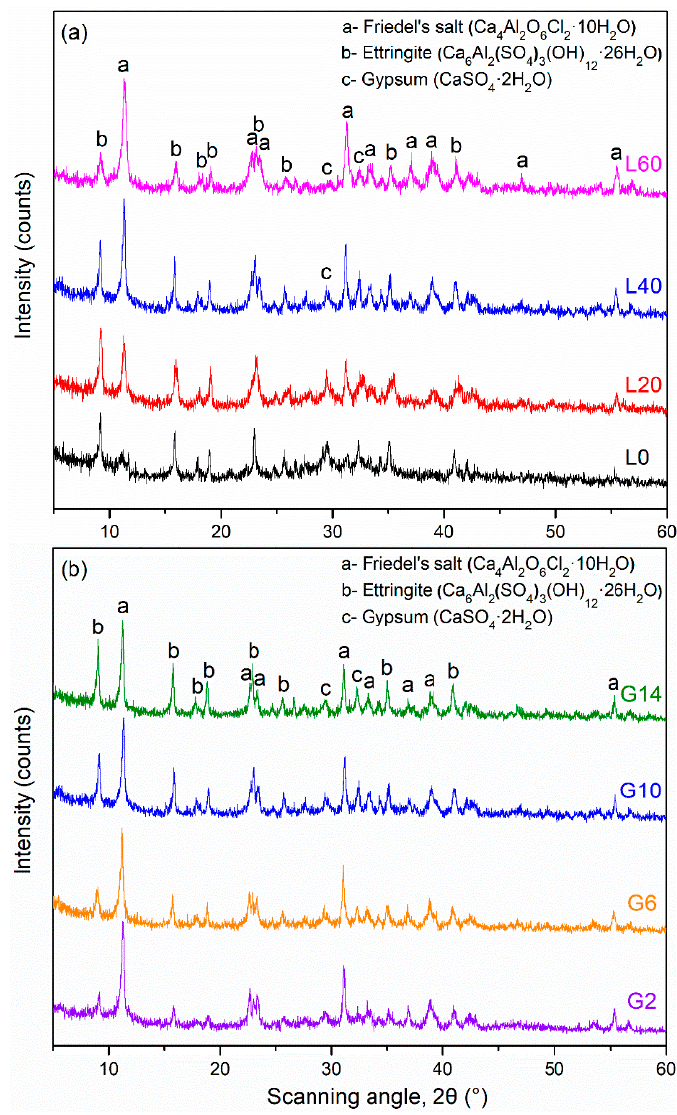
Figure 4. X-ray diffraction (XRD) patterns of pastes hydrated for 28 days ( a ) group L mixtures and ( b ) group G mixtures.